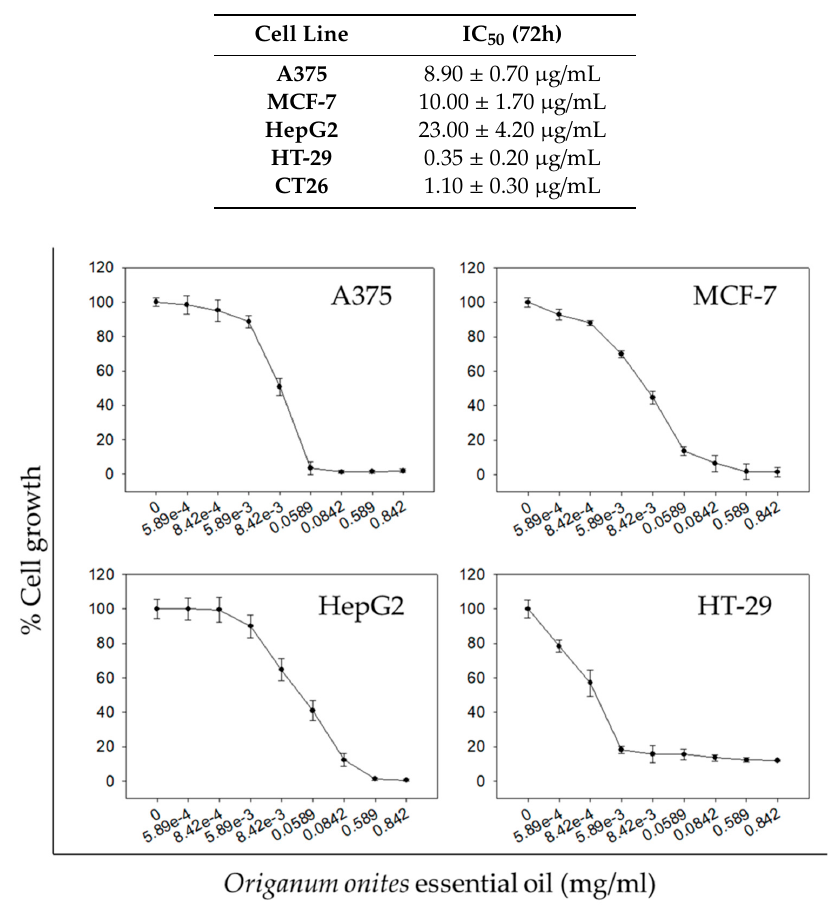
Figure 1. In vitro anticancer activity of OOEO against human cancer cell lines. Antiproliferative effect of increasing doses of OOEO at 72 h on human skin melanoma A375 cells, breast cancer MCF-7 cells, hepatocellular carcinoma HepG2 cells, and colon cancer HT-29 cells. Cell growth percentage was analyzed with the sulforhodamine B (SRB) assay. All data shown are representative of at least three independent experiments. Values represent mean ± SD.